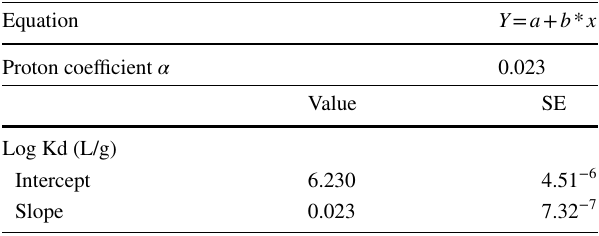
Fig. 5 Plot of Log Kd (distribution coefficient) versus final pH for CuO–kaolinite composite used for the determination of proton coef- ficient Table 2 Statistical presentation of proton coefficient for CuO–kaolin- ite composite derived from Fig. 5